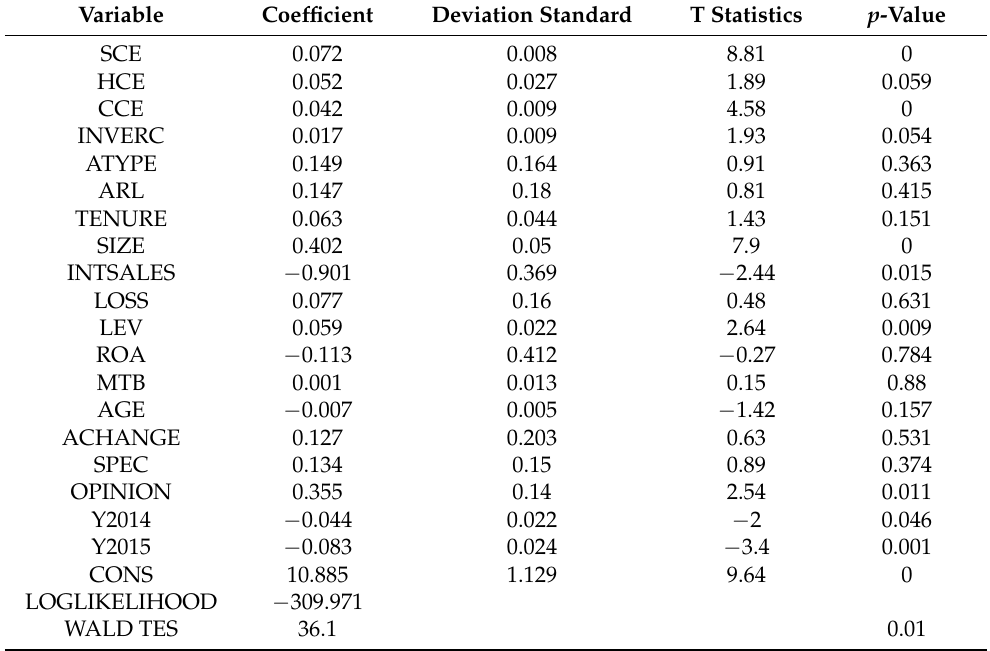
Table 15. The results of estimating the fourth model by the FGLS method.